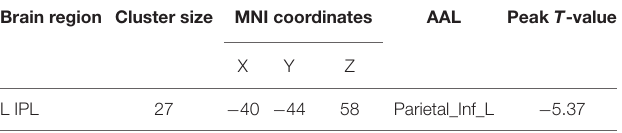
TABLE 2 | ALFF differences between the ASD group and TD group. Brain region Cluster size MNI